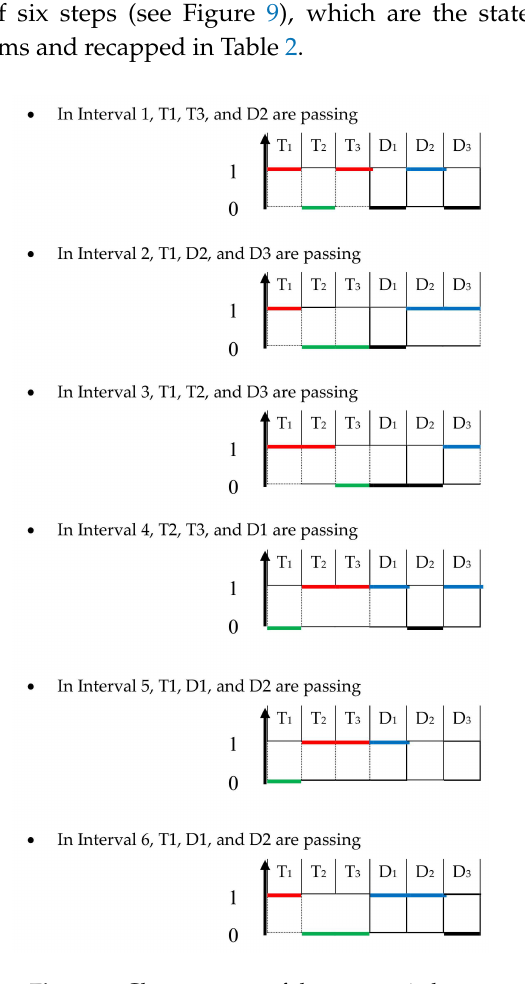
Figure 9. Chronograms of the stats switches.